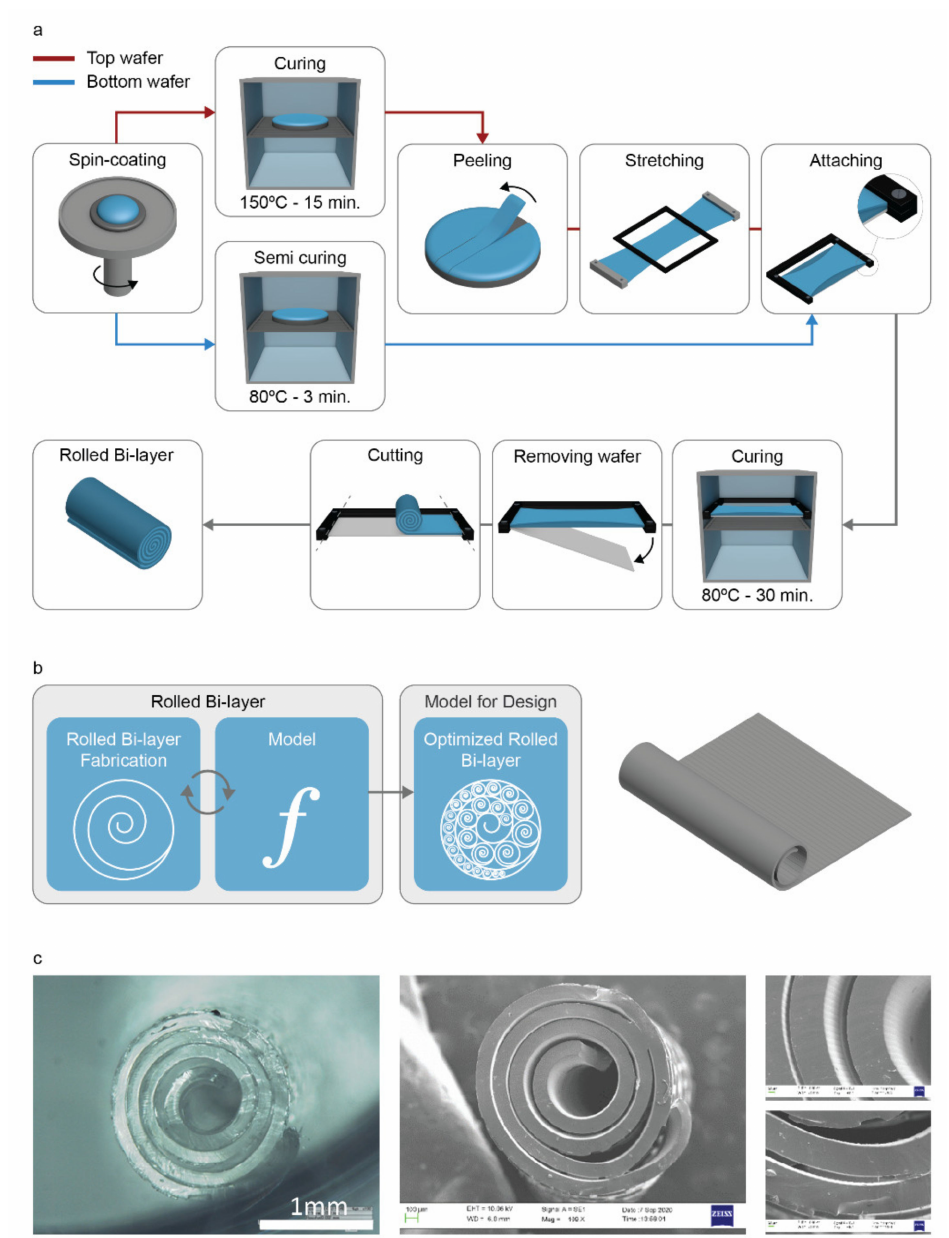
Figure 1. ( a ) Schematic of the fabrication process (rolled bilayers). ( b ) Depiction of the workflow followed: the bilayers’ fabrication allows validating the model. ( c ) Optical and SEM images of a rolled bilayer, fabricated using a spin coating speed of 1500 rpm, showing inner and outer surfaces provided with microgrooves and pillars,